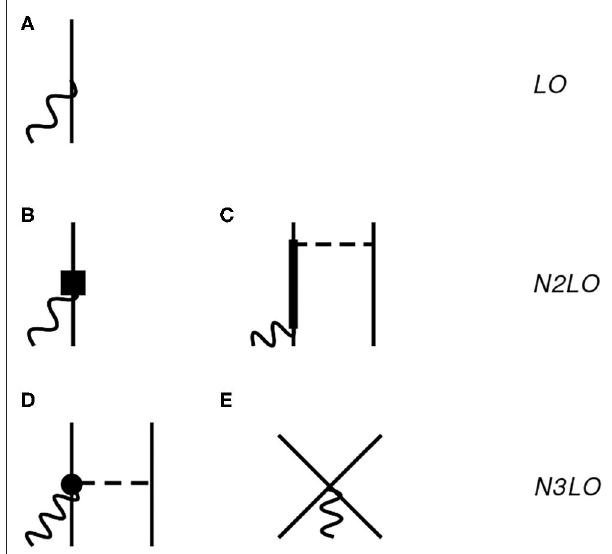
FIGURE 1 | Diagrams illustrating the contributions to the axial current up to N3LO ( Q 0 ) used in this work. Nucleons, 1 -isobars, pions, and external fields are denoted by solid, thick-solid, dashed, and wavy lines, respectively. The diagrams in (A,B) represent the leading order one-body term and its relativistic correction (denoted by the square vertex), respectively. The remaining diagrams, (C–E) provide two-body corrections to the one-body terms. The dot in (D) denotes a vertex induced by subleading terms in the π -nucleon chiral Lagrangian [26]. Only a single time ordering is